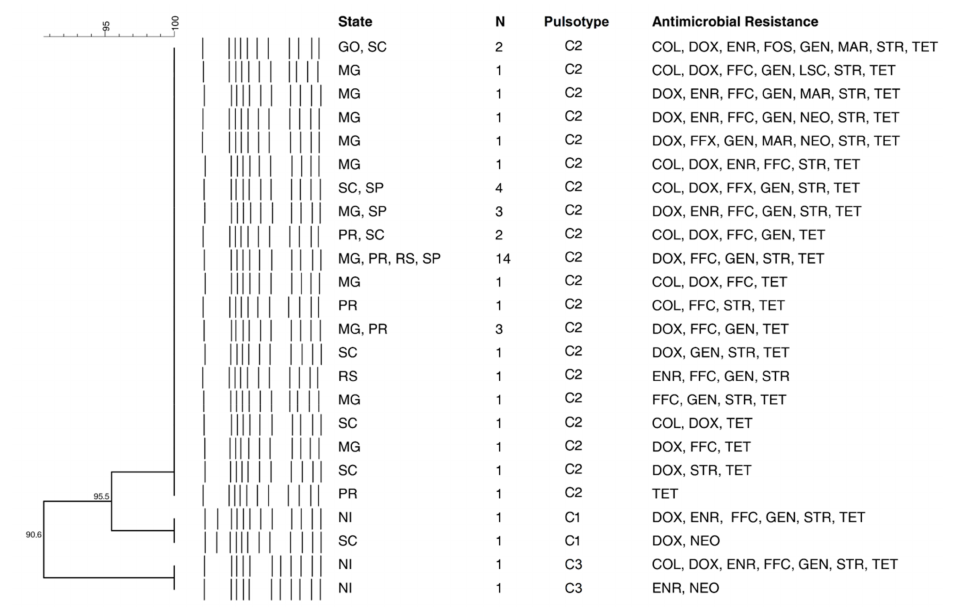
Figure 3. Salmonella Choleraesuis isolates segregated by pulsotype (PFGE technique) and antimicro- bial resistance profile. The outbreak location by state and the number of isolates are indicated for each pattern. N = number of